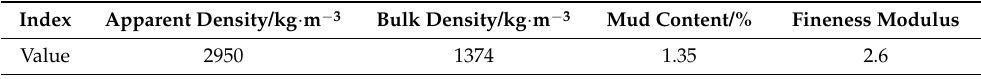
Table 1. Physical index of fine